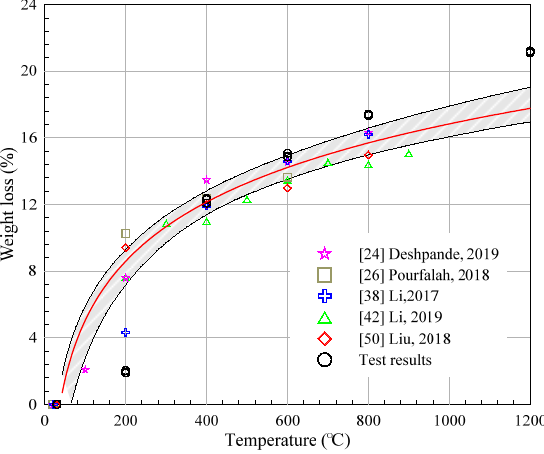
Figure 9. Weight loss at different temperatures from the literature and present study.